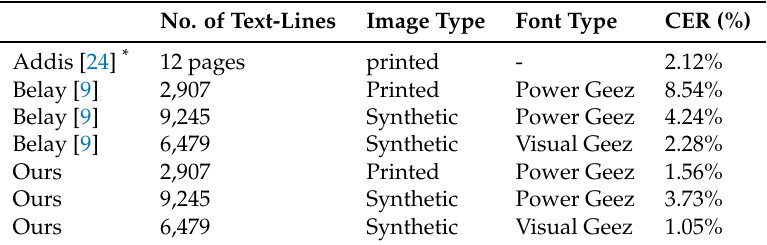
Table 5. Comparison of test results